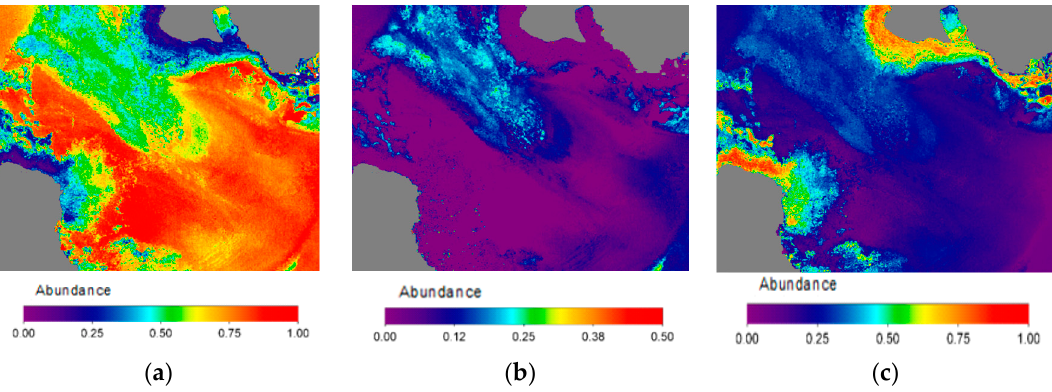
Figure 10. Result of the bottom lineal unmixing: ( a ) sand endmember abundance; ( b ) algae endmember abundance; ( c ) sediment-rock endmember abundance.